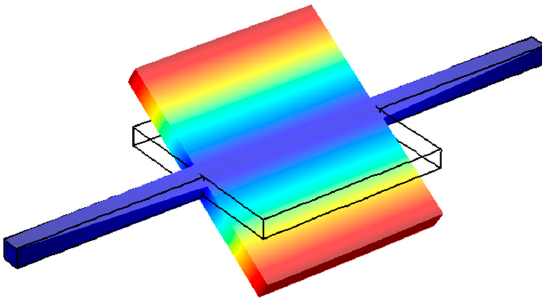
Figure 10. A torsional mode paddle resonator.